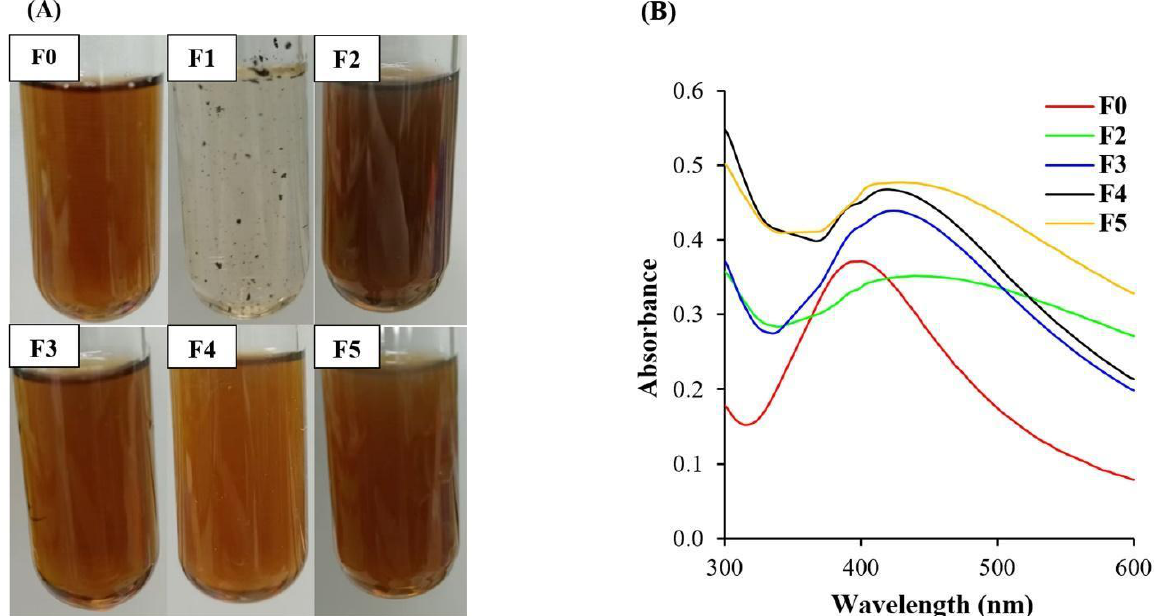
Figure 1. Appearance and UV-Vis spectra of nanoparticles. ( A ) The appearance of nanoparticles in the preparation of F0 (AgNPs) and F1–F5 (Col-AgNPs), and ( B ) UV-Vis spectra between 300 and 600 nm of F0 and F2 – F5 .